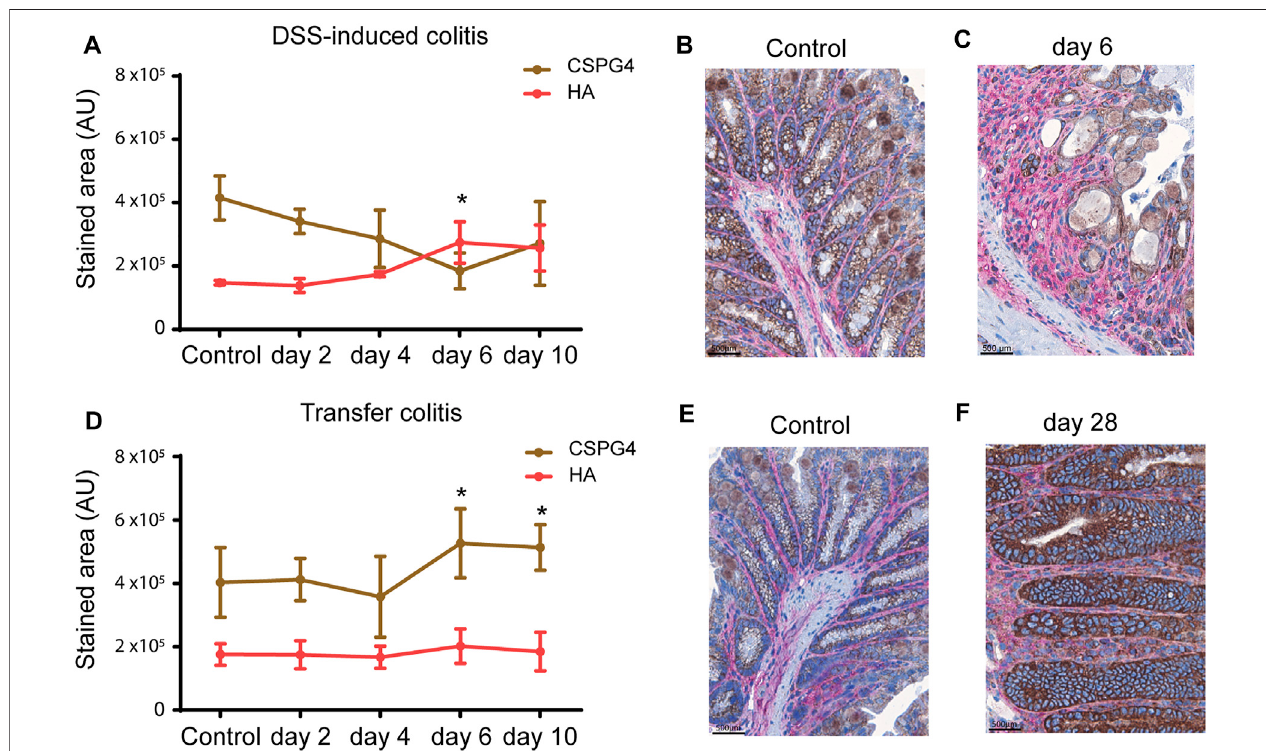
FIGURE 3 | HA and chondroitin sulfate are differently expressed in health and intestinal in fl ammation as well as in DSS-induced colitis and transfer colitis. (A) Expression of HA (red) and CSPG4 (brown) quanti fi ed as positive stained area (mean AU ± SD) on day 2 ( n = 5), day 4 ( n = 4), day 6 ( n = 9) and day 10 ( n = 12) show an increase in HA and decrease in CPSG4 compared to controls ( n = 3). Representative images of colon sections from mice with DSS-induced colitis immunohistochemically stained for HA (red) and CSPG4 (brown) shown for healthy (B) and in fl amed colon (C) . (D) Expression of HA and CSPG4 quanti fi ed as positive stained area (mean AU ± SD) on day 14 ( n = 3), day 21 ( n = 5), day 28 ( n = 6) and day 41 ( n = 9) show no changes in HA content but an increase in CSPG4 compared to controls ( n = 24). Representative images of colon sections from mice with transfer colitis immunohistochemically stained for HA (red) and CSPG4 (brown) shown for healthy (E) and in fl amed colon (F)